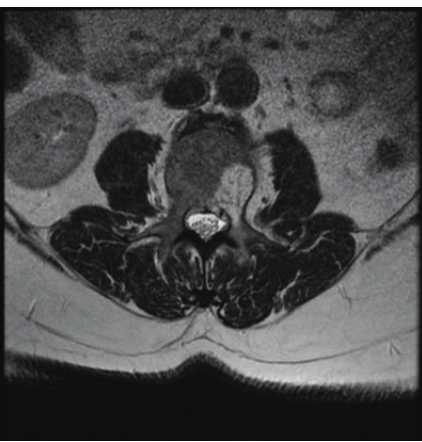
Figure 1: MRI of the spine; T2 weighted images demonstrating hyper intense skeletal lesions.